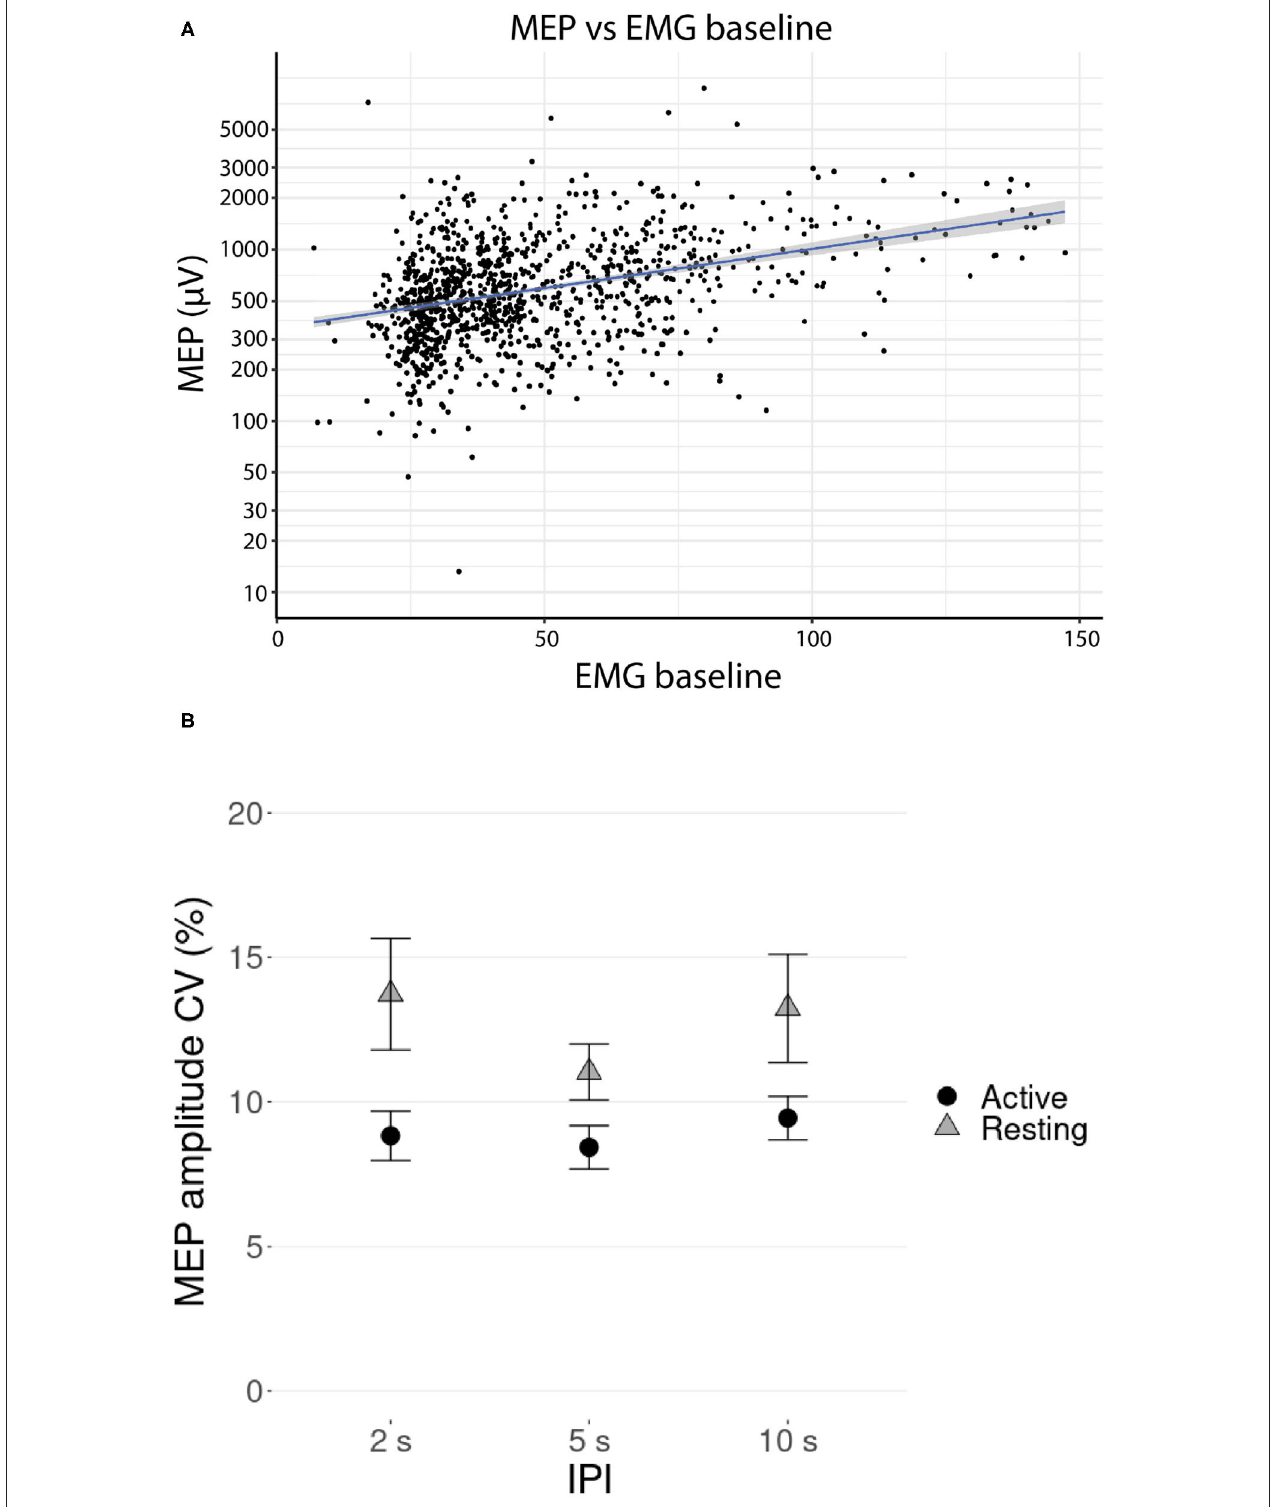
FIGURE 2 | (A) Relationship between the MEP amplitudes and the EMG baseline (RMS value over 1 s before the stimulus) during TMS stimulation with active contraction on logarithmic scale. Participant-specific intercepts have been removed from the data using a linear mixed effects model. The gray shaded area around the regression line represents the 95% confidence interval. (B) Mean coefficient of variation (CV) of the log transformed MEP amplitude versus IPI at active and resting conditions. Error bars represent the standard errors.